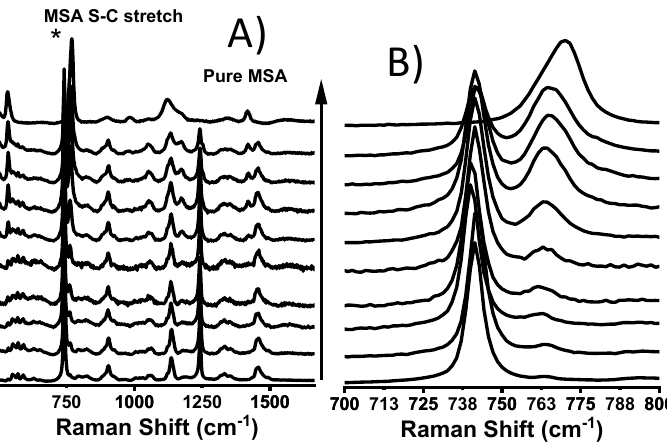
Figure 4. Raman spectra of MSA in PyrrTFSI shown with increasing MSA concentration from 0 to 5.0 M. The top trace is the Raman spectrum of pure MSA. ( A ) Full spectra; ( B ) Expanded region between 700 and 800 cm − 1 to correspond to the region discussed in the text.